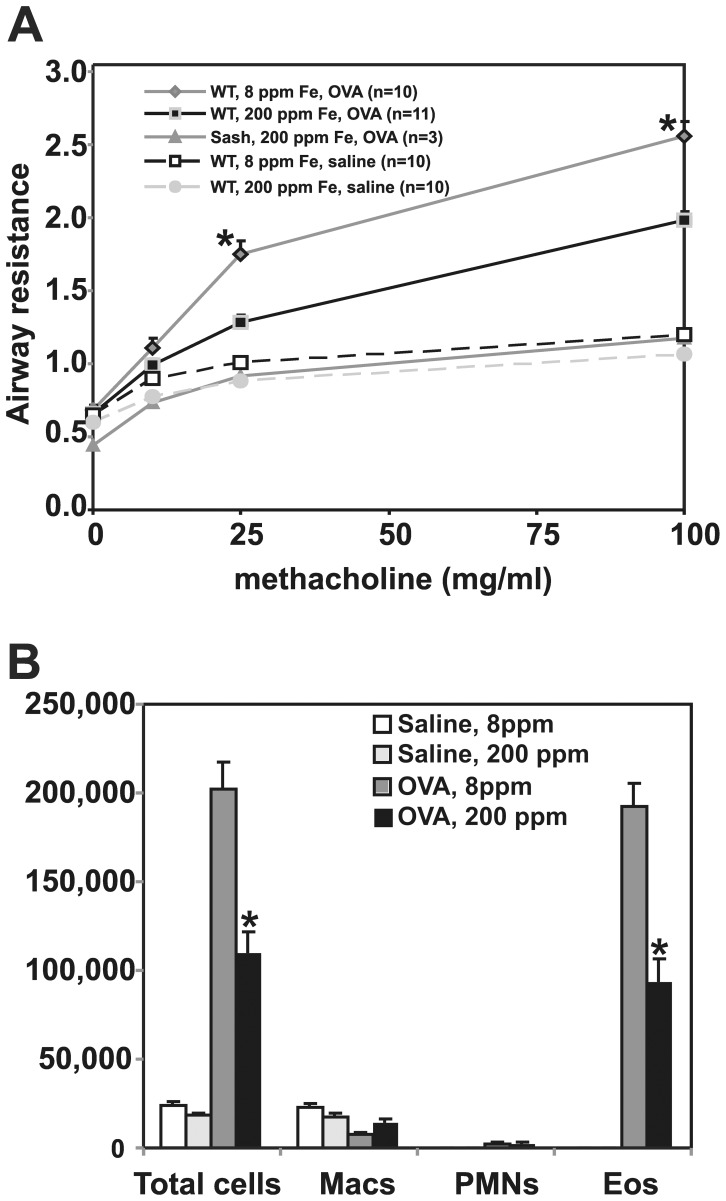
Iron supplementation decreases severity of allergic asthma.WT and mast cell-deficient Sash mice on the indicated diets were sensitized to OVA then challenged with OVA or saline. A. Airway resistance (measured in units of cm H2O/ml/sec) in response to methacholine was significantly decreased following allergen challenge for mice that received iron supplementation (*indicates p≤0.0005). B. Iron supplementation decreased infiltration of eosinophils into bronchoalveolar spaces (decrease of 52%; *indicates p = 0.0007).